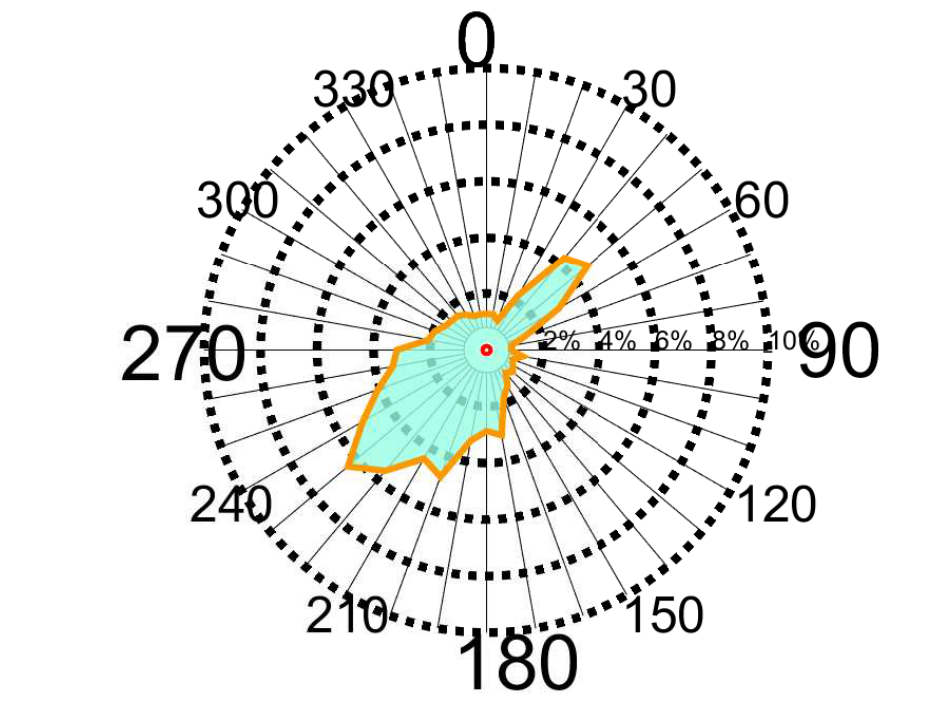
Figure 12. Rose portrait of WD (North direction = 0 ◦ ) in OSWFs in Yangshan port, Shanghai from 22 August 2017 to 22 August